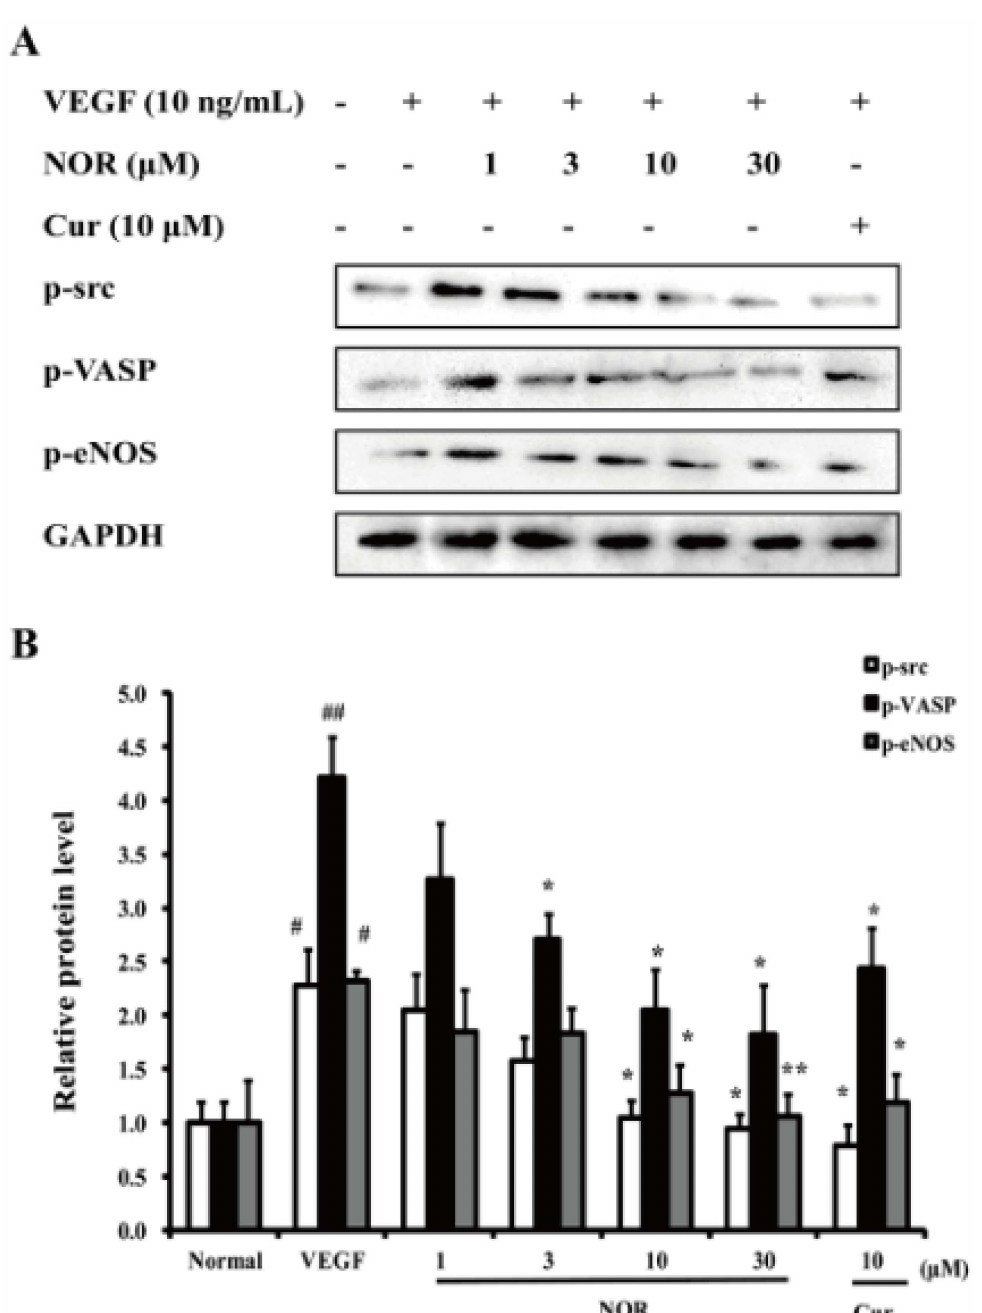
Figure 5. The effect of NOR on the VEGF-induced activation of various kinases in the PKA pathway. ( A ). Effect of NOR on VEGF-induced expressions of p-src, p-VASP and p-eNOS. HUVECs were pretreated with NOR for 24 h, stimulated by VEGF for 20 min, and then harvested for western blot analysis. ( B ) Quantification of p-src, p-VASP and p-eNOS expressions. The data were expressed as mean 6 SD of three independent experiments. # P , 0.05, ## P , 0.01 vs . normal group; * P , 0.05, ** P , 0.01 vs . VEGF group. NOR, norisoboldine; Cur,